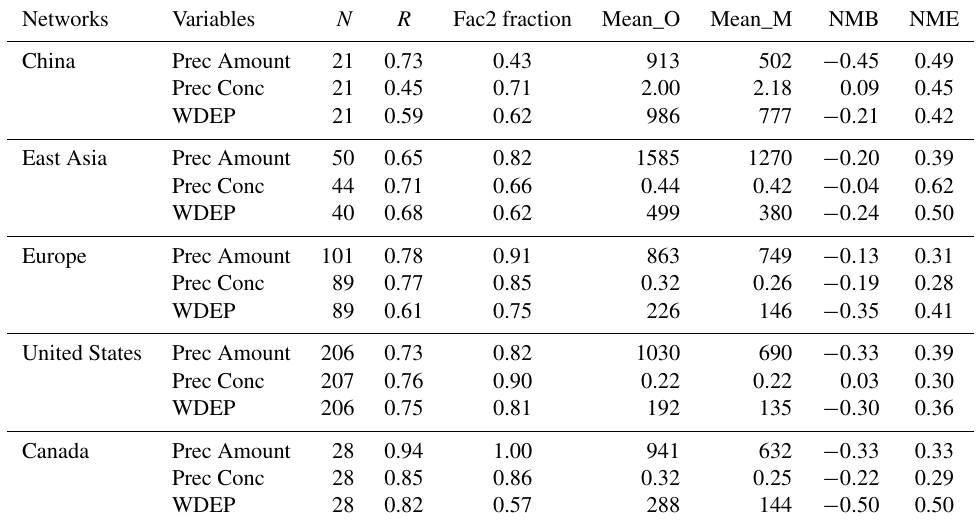
Table 6. Summary statistics of model comparison with measurements for annual precipitation (Prec Amount, mm), precipitation-weighted mean concentration of NH 4 + (Prec Conc, mgNL − 1 ), and wet deposition of reduced N (WDEP, mgNm − 2 ) in 2015. N is the number of measuring sites. R is Pearson’s coefficient. Fac2 is the fraction of data points that are within a factor of 2. Mean_O and Mean_M of Prec Conc are annual averages of observation and model, respectively. Mean_O and Mean_M of Prec Amount and WDEP are annual totals. NMB is normalized mean bias, and NME is normalized mean error.